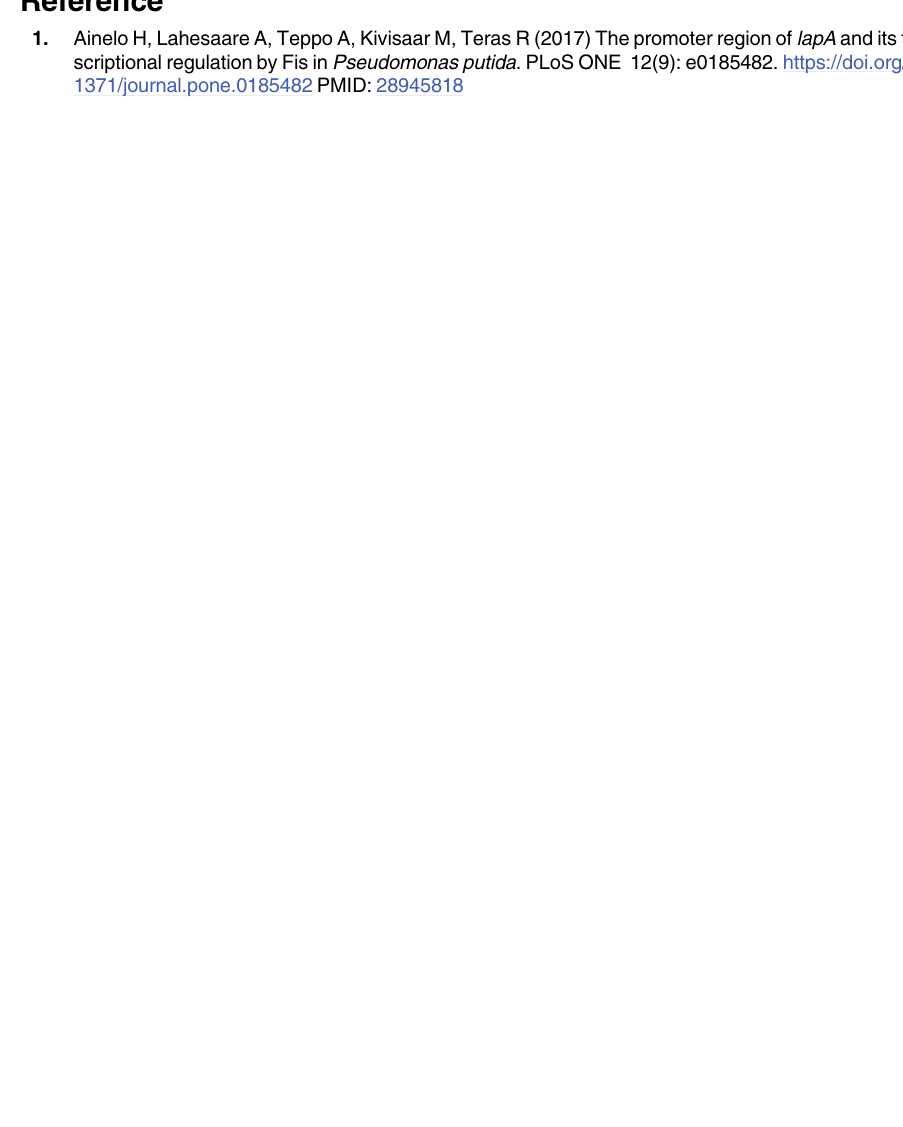
Table 1 appears incorrectly. Separately analyzed groups of data should be divided by bold hori- zontal lines and background color. Please see the corrected Table 1